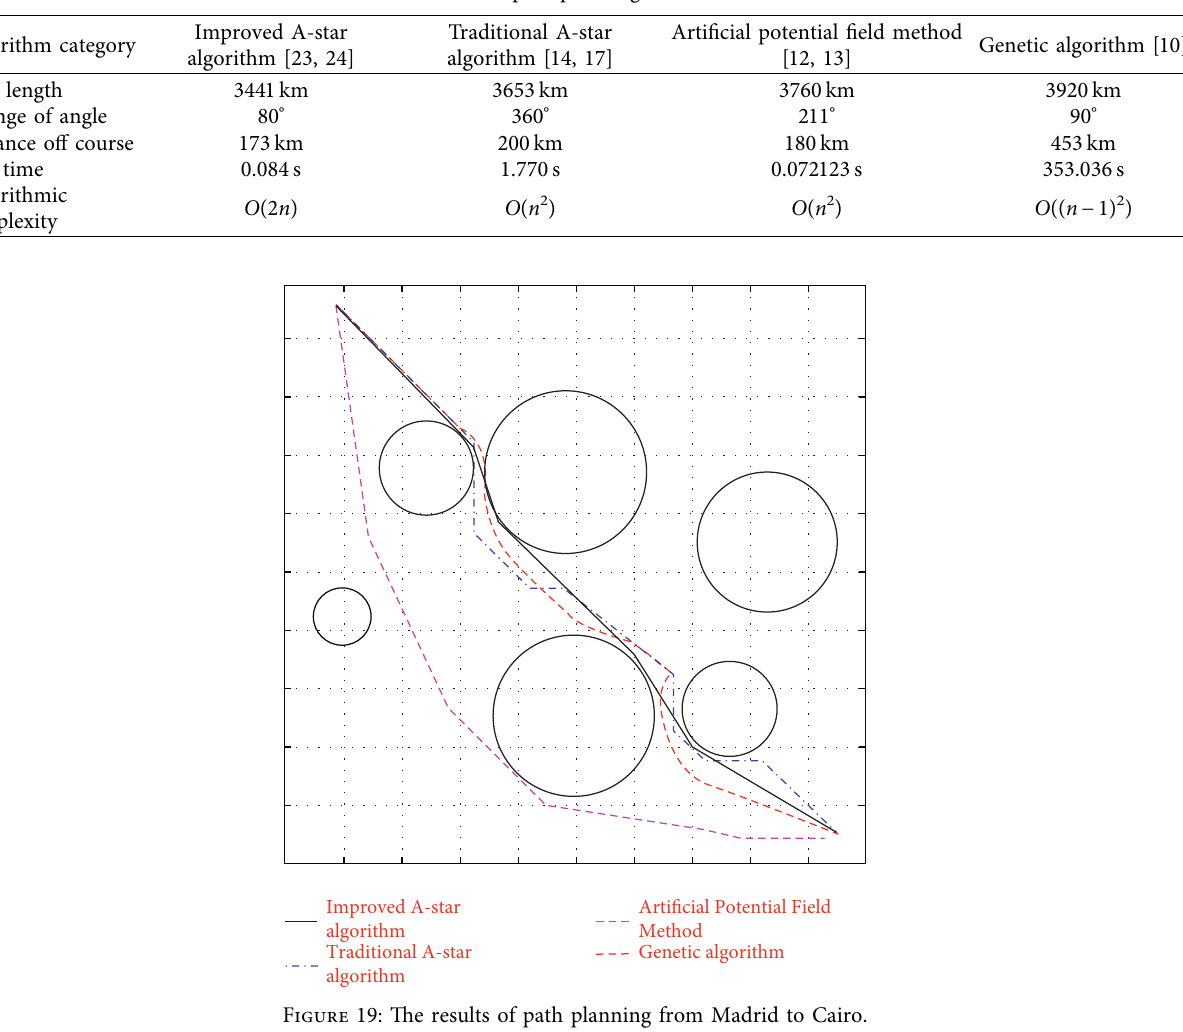
Table 6: The results of path planning from Madrid to Cairo.